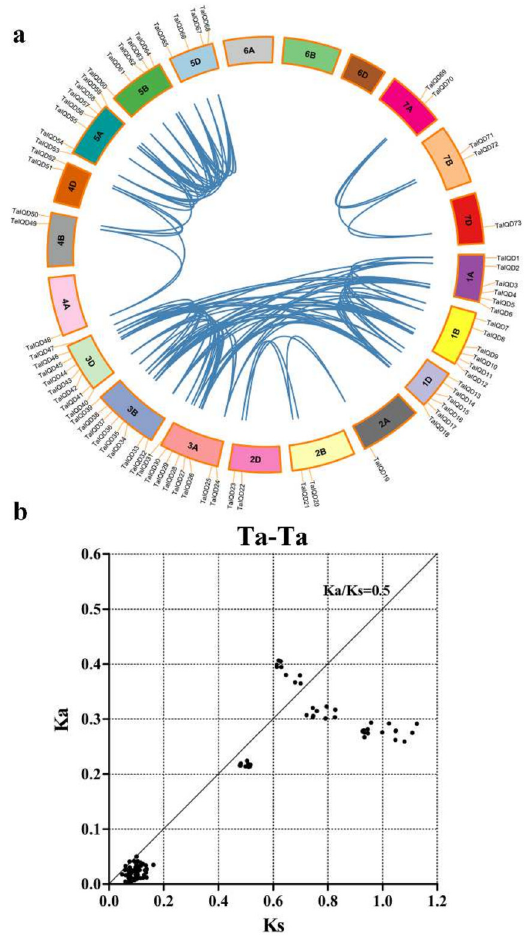
Figure 3. Chromosomal locations and gene duplications of TaIQD genes. ( a ) Chromosomal localiza- tions of the TaIQDs . Different wheat chromosomes are presented in different colors. The blue lines indicate duplicated IQD gene pairs. The chromosome number is displayed next to each chromosome. ( b ) The Ka and Ks distributions of 111 duplicated gene pairs exhibited in a